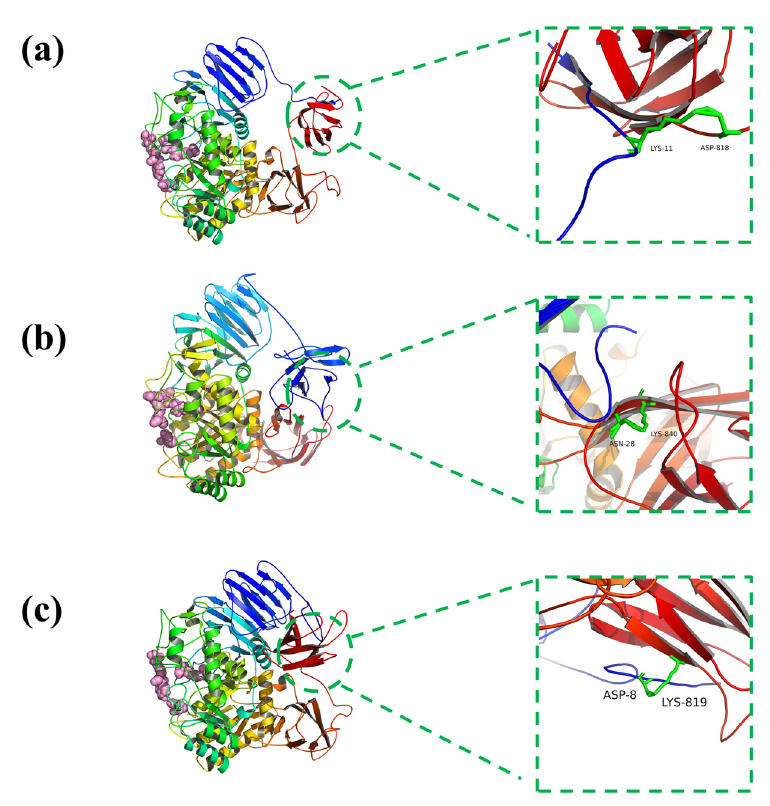
Figure 7. 3D structure of cyclized AGL (the pink spheres highlight the enzyme active sites). ( a ) SpyTag-AGL-SpyCatcher, ( b ) SnoopTag-AGL-SnoopCatcher, ( c ) SdyTag-AGL-SdyCatcher.